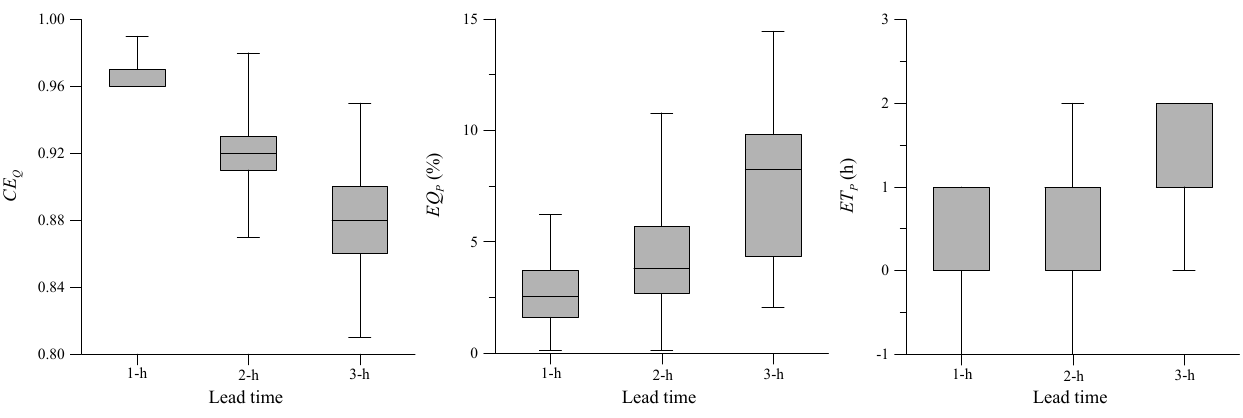
Figure 8. Results of evaluated criteria for flow forecasting using measured rainfall and flow updating technique.